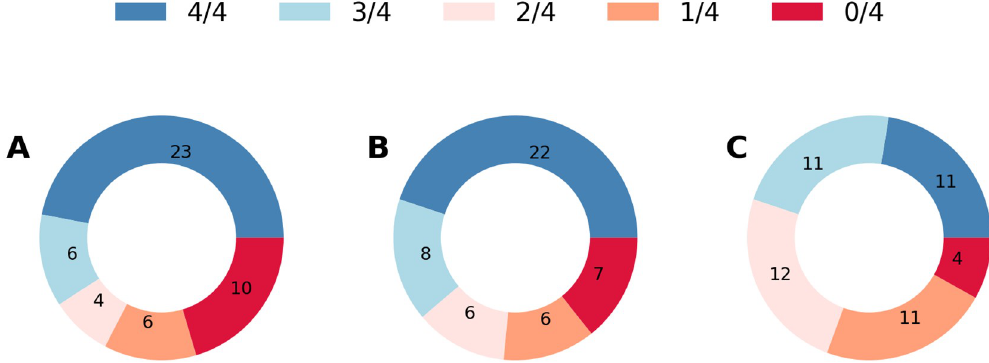
Fig 14. The number of the states where the former network outperforms the latter network in 0, 1, 2, 3, or all 4 metrics (RMSE, MAPE, L2E, and PCORR). A. TCN against Seq2Seq, B. SNAIL against Seq2Seq, and C. SNAIL against TCN. The numbers shown in this figure are collected from all 49 states.